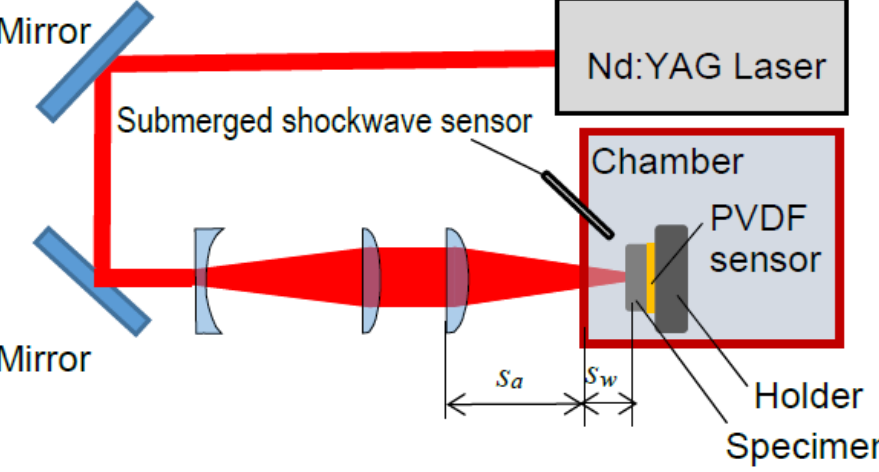
Figure 1. Schematic diagram of the submerged laser peening system. PVDF, polyvinylidene fluoride; s a , distance in air; s w , distance in water.